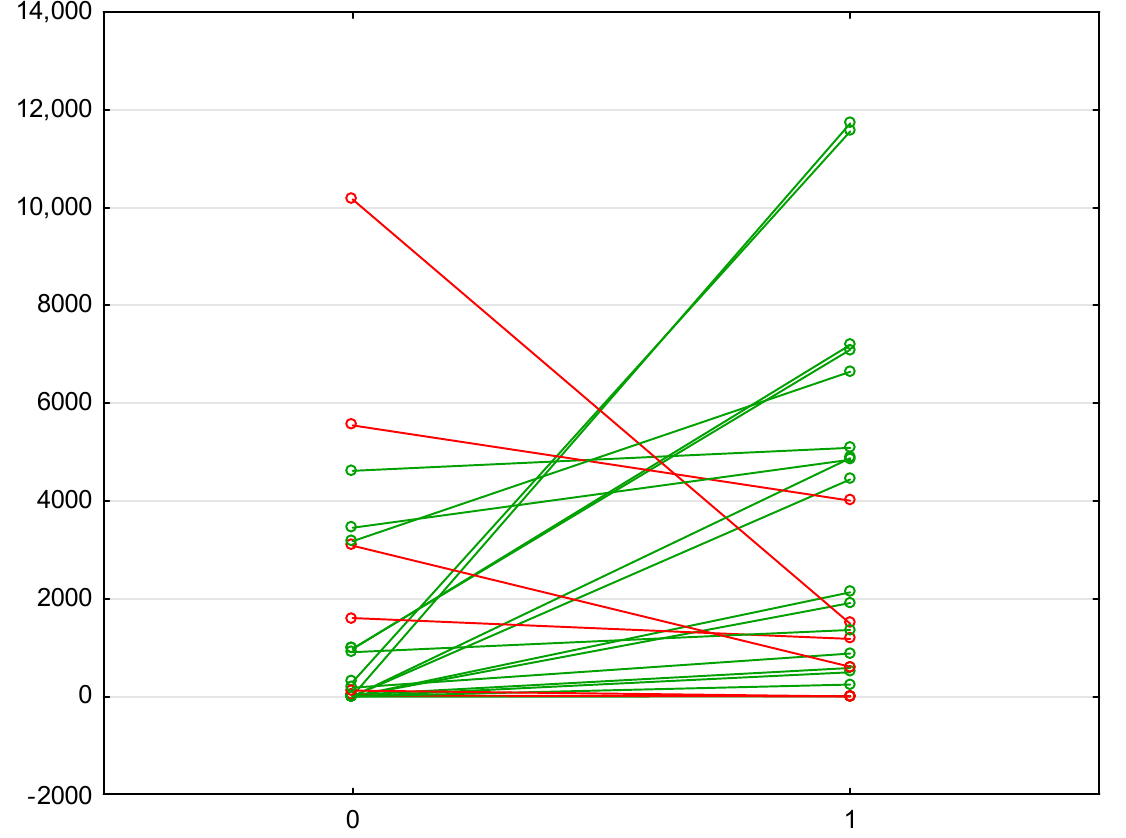
Figure 4. Changes in the expression of BDNF mRNA before and after biological therapy. Anti-TNF therapy with either infliximab or adalimumab increased the level of mRNA BDNF expression, while decreasing anti-TNF mRNA ( p = 0.009, p = 0.045). Abbreviations: BDNF—Brain-Derived Neurotrophic Factor. Green color indicates an increase, red decrease. severity of insomnia symptoms (AIS score) at the baseline (r = − 0.409, p = 0.042; Table 6; Figure 5a), poor sleep quality (r = − 0.441, p = 0.027; Table 6; Figure